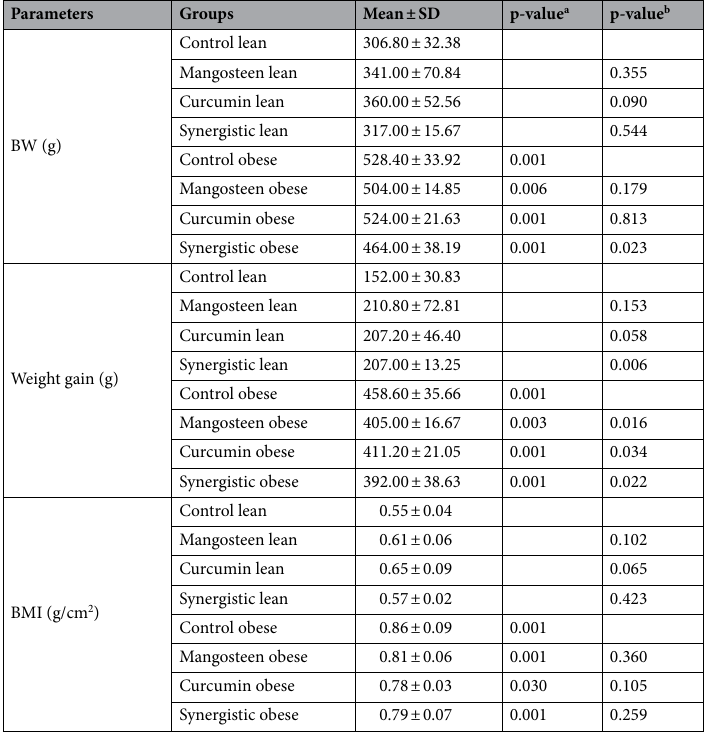
Table 1. Independent and synergistic effects of curcumin and mangosteen extracts on BMI of lean and HFD-induced obese rats. a Significant difference between normal weight and obese rats in each group (control, mangosteen, curcumin, and synergistic). b Significant difference between each group and respective normal weight or obese control